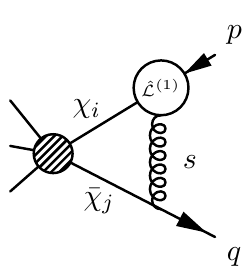
(1) , that gives (cid:24) i L